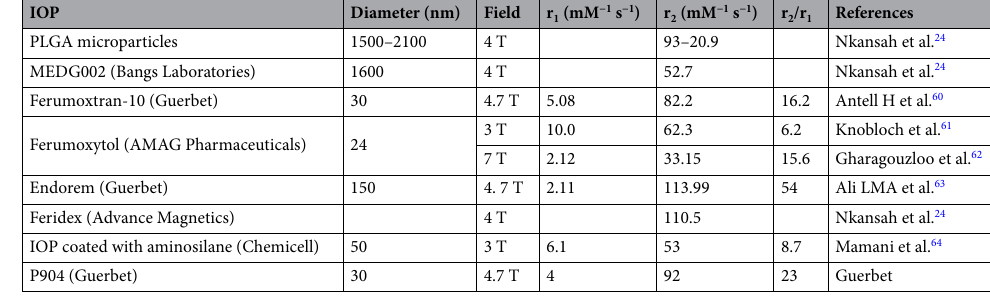
Table 1. Relaxivities of various particles at high magnetic fields. The names, sizes and relaxivities are shown at the corresponding magnetic